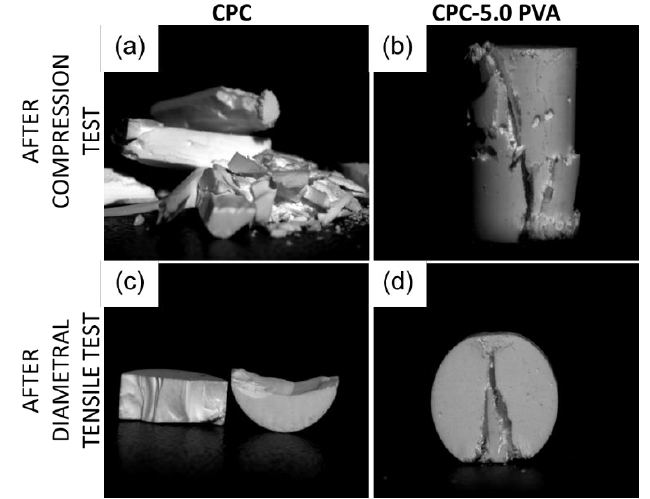
Figure 4. Pictures of the samples after compression of ( a ) group CPC and ( b ) group CPC-5.0 PVA; and after the diametral tensile test of ( c ) group CPC and ( d ) group CPC-5.0 PVA.